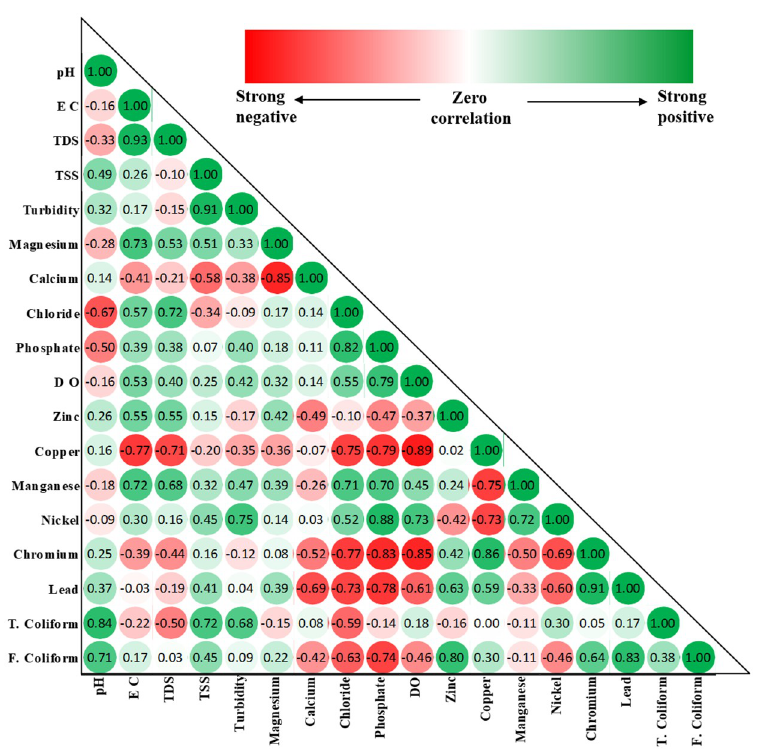
Fig 3. Pearson product moment correlation coefficients of log-transformed surface water data.